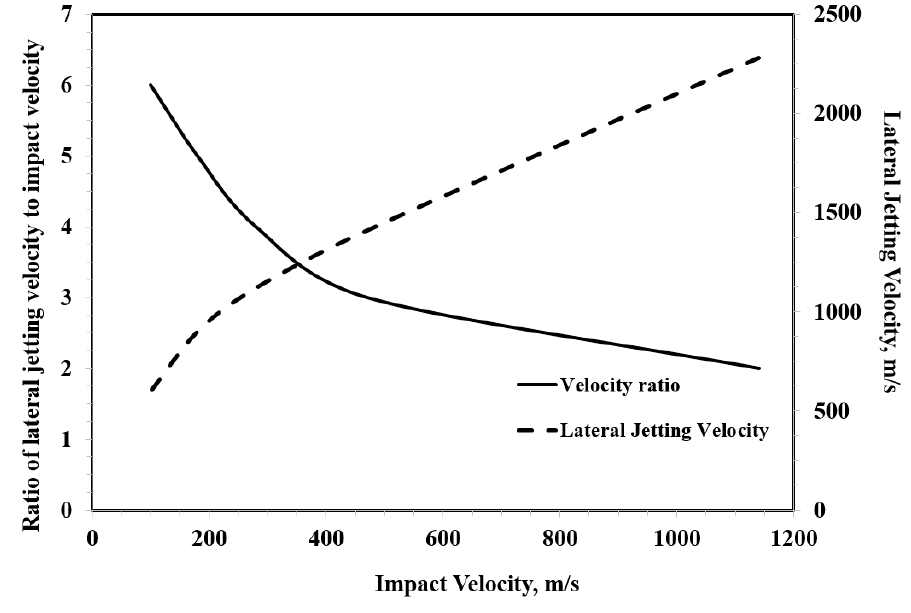
Figure 9. Lateral jetting velocity as a function of impact velocity. Redrawn from [76].